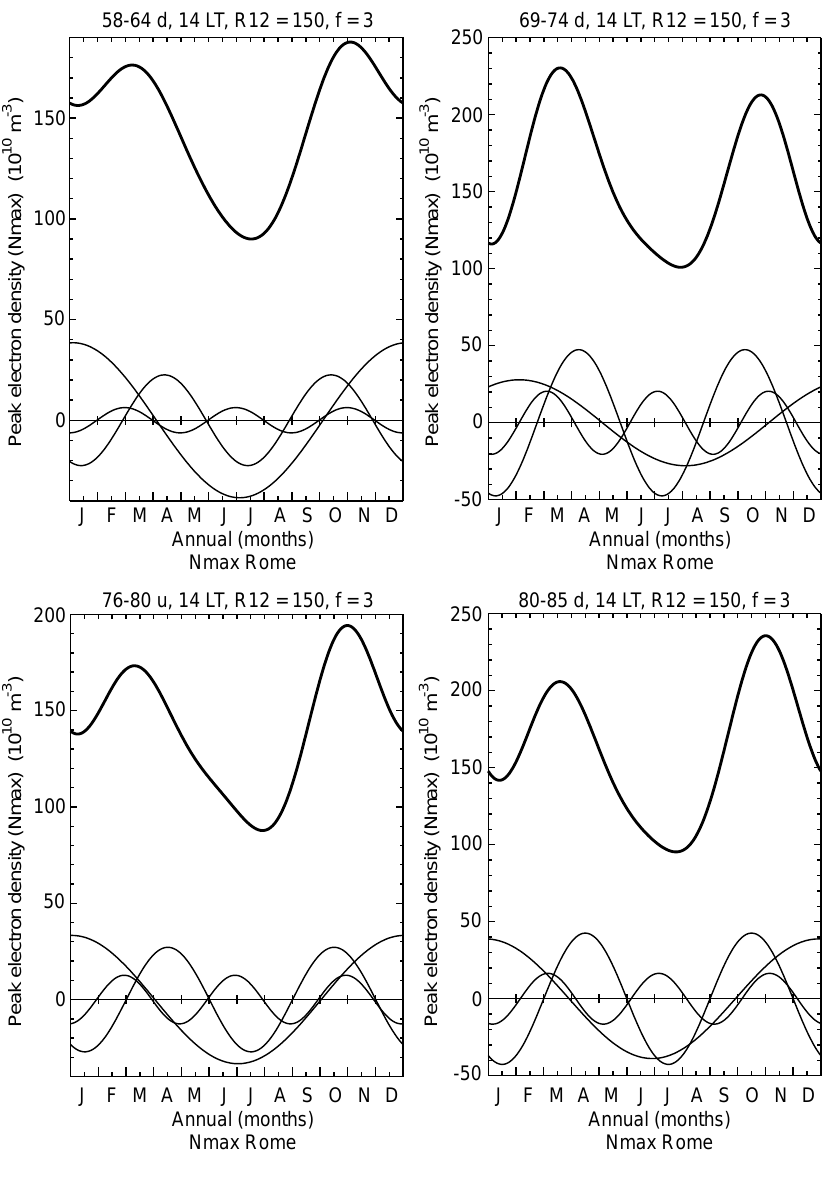
Fig. 7. Annual variation of peak electron density ( N max ) from four Fourier components (mean, 1 year, 1/2 year, 4 months). High solar activity ( R 12 (cid:136) 150, from regression), solar cycle 19 falling part ( top, left-hand side ), 20 falling part ( top, right-hand side ), 21 rising part ( bottom, left-hand side ) and 21 falling part ( bottom, right-hand side ). The 1-year, 1/2-year, 4-month components are shown separately ( thin